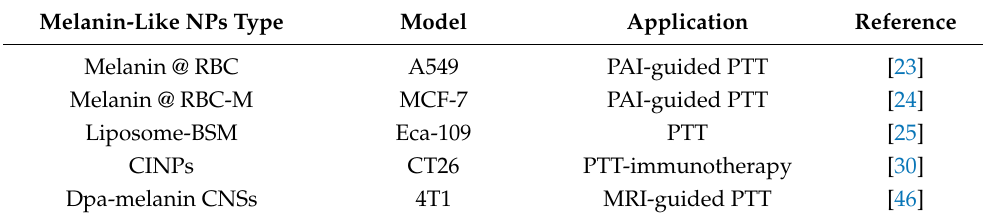
Figure 8. Melanin @ RBC NPs for enhanced PTT. ( a ) Schematic illustration of the preparation of red blood membrane camouflaged melanin nanoparticles and PAI guided PTT. ( b ) PA signal versus various concentrations of melanin or Melanin @ RBC NPs in vitro. Inset is the PA images of Melanin @ RBC NPs with different concentrations. ( c ) Ultrasound (UA) images, PA images, and merged images in tumor region before and after intravenous injection of Melanin @ RBC NPs in A549 tumor-bearing mice. ( d ) Photos of tumors dissected from each group on the 13th day after PTT and comparison of tumor weight of different groups [26]. (** p < 0.01, *** p < 0.001 and n.s. represents no significance.) Table 2. Examples of melanin-like NPs for photothermal therapy